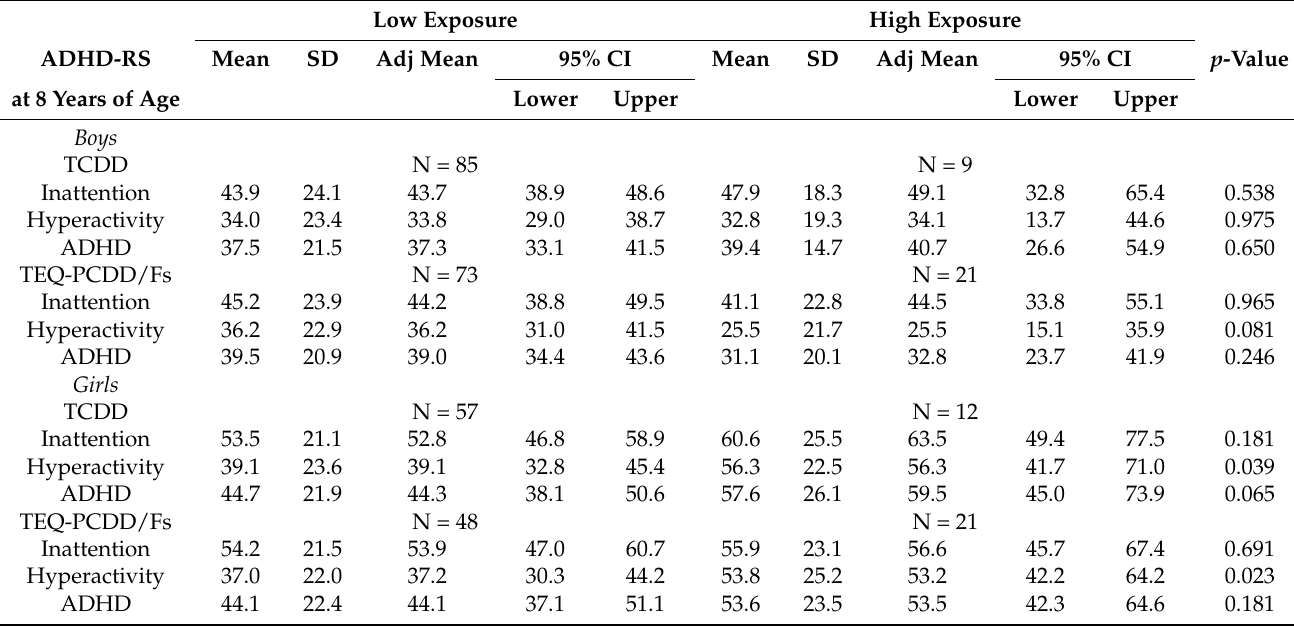
Table 3. Adjusted comparisons of ADHD scores at 8 years of age between high and low expo- sure groups.